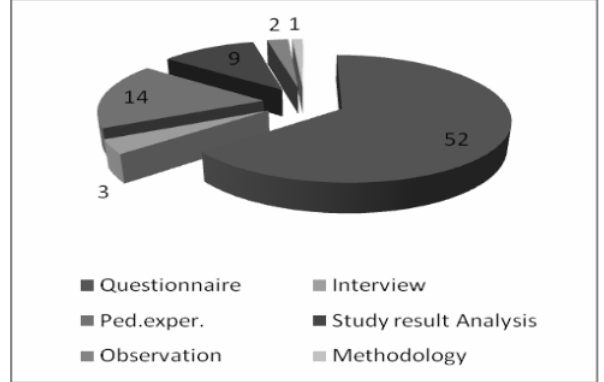
Figure 2. Research